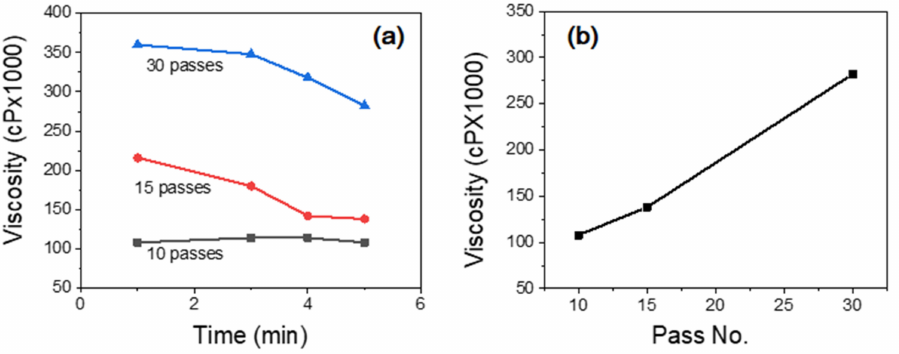
Figure 1. Photograph of ChNF suspensions: ( a ) the original chitosan; ( b ) after 10 ACC passes; ( c ) after 15 ACC passes; and ( d ) after 30 ACC passes.